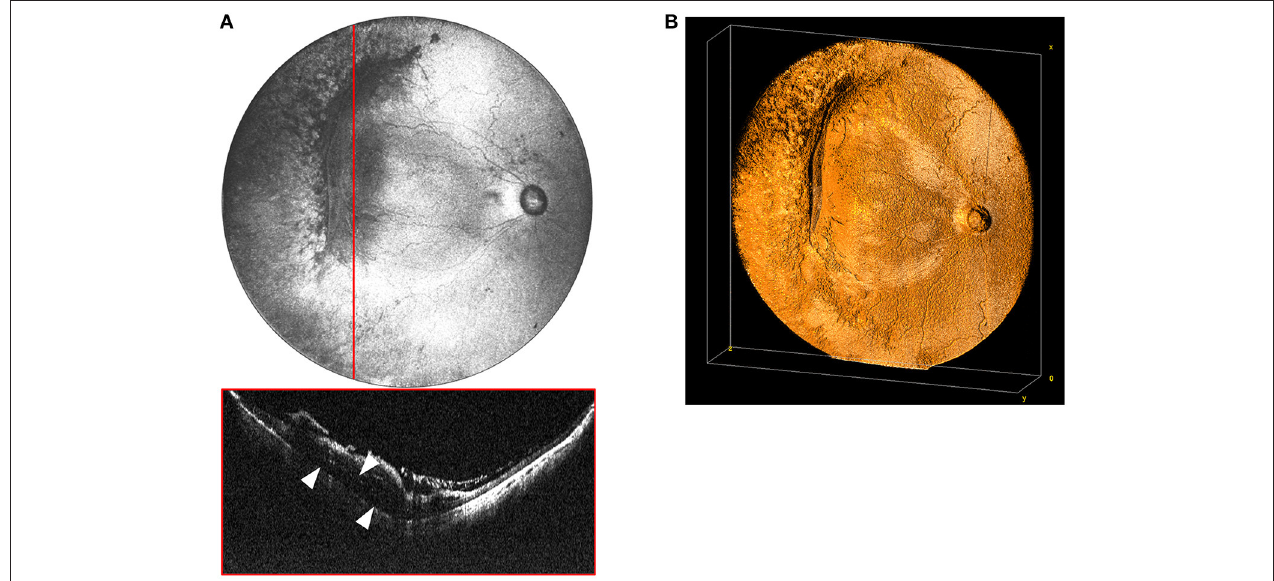
FIGURE 4 | (A) Widefield en face OCT image of a stage 4A tractional retinal detachment secondary to ROP. These images are from a baby born at 25 weeks gestation (571g) and imaged at 50 weeks postmenstrual age. Red horizontal line indicates location of the corresponding cross-sectional B-scan. White arrows designate area of retinal detachment with subretinal fluid. (B) Volumetric rendering of retinal detachment shown in 4A. This visualization enables topographic representation of the three-dimensional relationships in severe retinopathy of prematurity, including highlighting the elevation of the blood vessels and fibrovascular proliferation causing the retinal